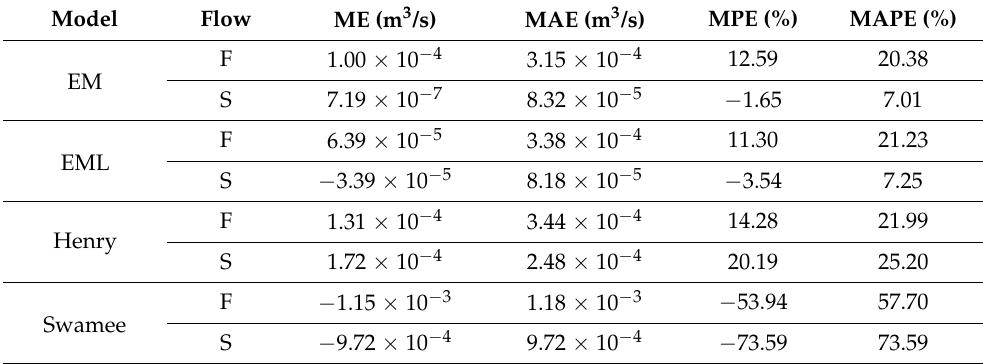
Table 3. The evaluation criteria for estimated flow